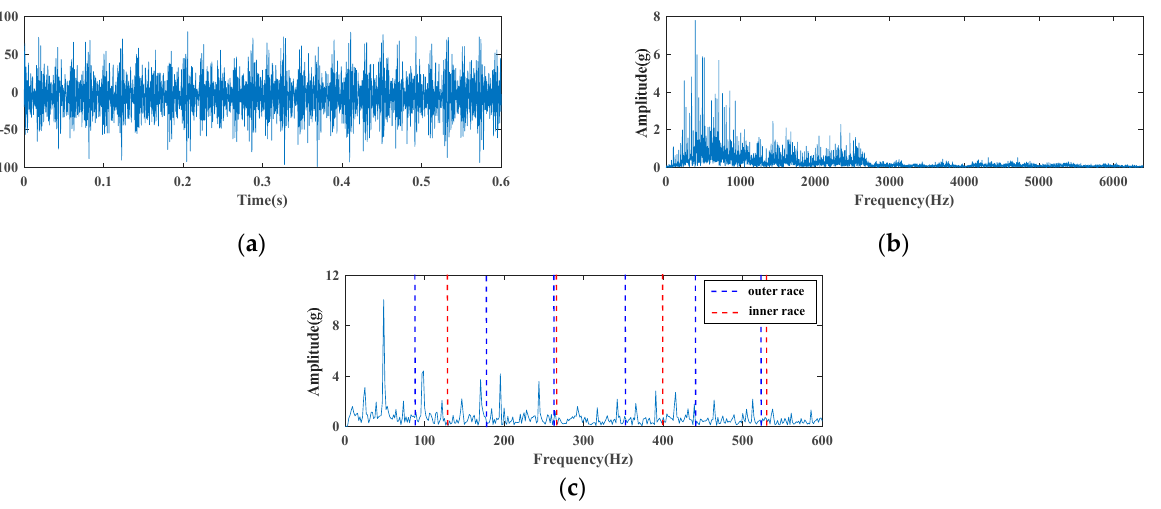
Figure 19. Experimental signal of bearing races compound fault: ( a ) waveform; ( b ) frequency spectrum; ( c ) envelope spectrum.